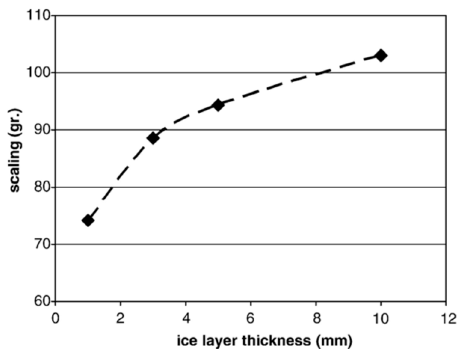
Figure 4. Cumulative mass scaling of identical samples with various ice-layer thicknesses (after three freezing–thawing cycles) [104].